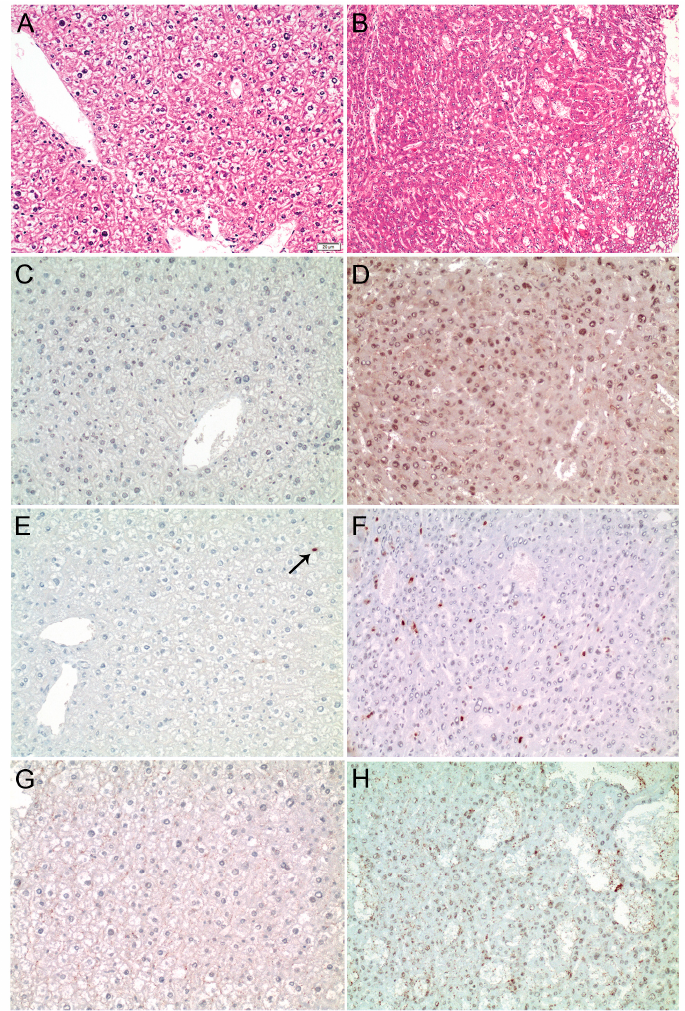
Figure 5. MDM4 is upregulated in SRF-VP16 iHep transgenic mice. ( A ) Normal liver parenchyma in control mice (HE staining). ( B ) Well-differentiated HCC in a 30-week-old SRF-VP16 iHep mouse showing trabecular disarray and pseudogland formation. MDM4 immunostaining is negative in control mice ( C ), while a diffuse, predominantly nuclear staining is seen in SRF-VP16 iHep mice ( D ). Individual hepatocyte nuclei (arrow) are positive for phosphorylated-ELK1 in the control liver ( E ), whereas the number of p-ELK1 positive nuclei is significantly increased in SRF-VP16 iHep mice ( F ). There is no ELK4 immunosignal in control mice ( G ). In contrast, the SRF-VP16-induced HCC reveals weak to moderate nuclear ELK4 staining ( H ). Scale bar: 20 µ